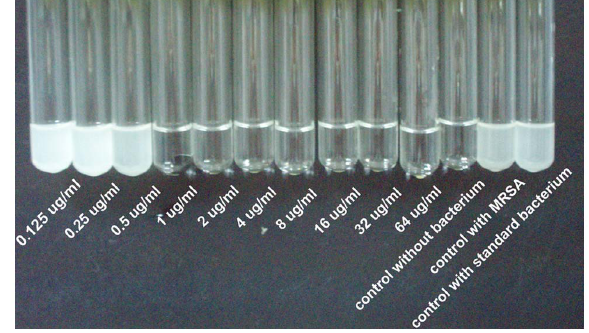
Figure 5. The MIC against MRSA for vancomycin was deter- mined using the antibiotic twofold tube-dilution method. Three no-drug tubes (not inoculated with any bacterium, inoculated with MRSA, and inoculated with standard bacterium) were also performed as control. MIC was the lowest concentration of antibiotic that prevented turbidity after 24 h of incubation at 37 u C. In this study, the MICs of all three groups (non-processed vancomycin, vancomycin released from borate BG cement and CS cement) were 1 m g/mL.